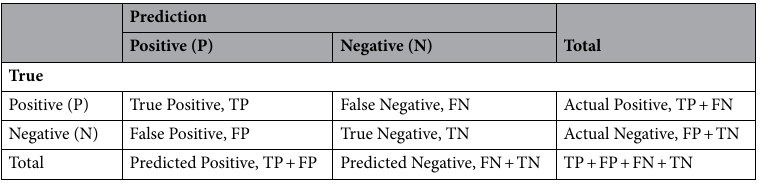
Table 2. Classification theory matrix of ROC